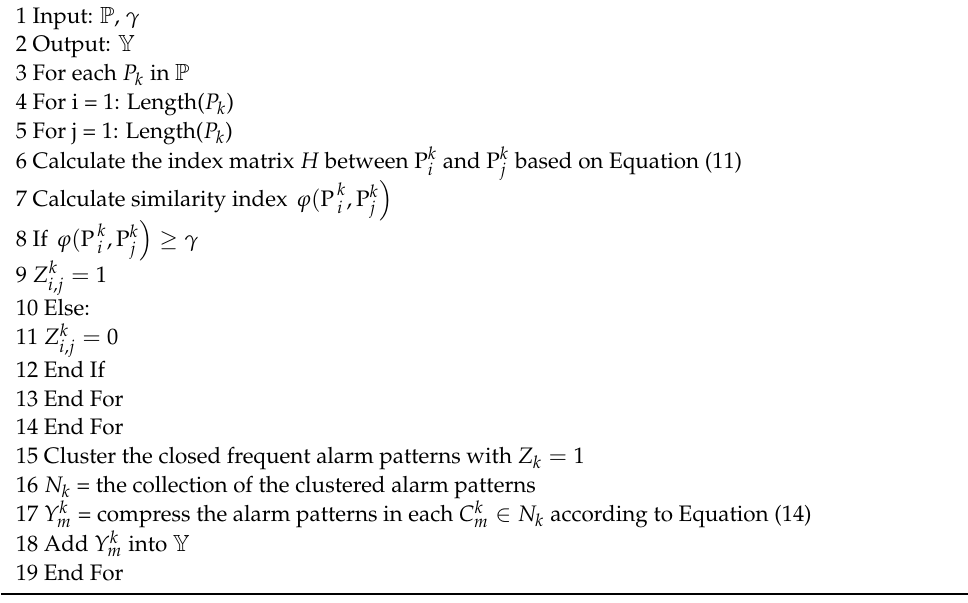
Algorithm 3 Major codes for compressing alarm patterns in